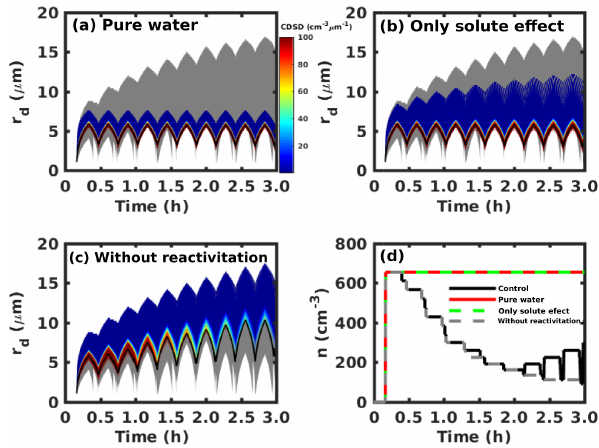
Figure 3. (a) Cloud droplet size distribution (CDSD) changes with time without solute or curvature effects. (b) CDSC changes with time with the solute effect but without the curvature effect. (c) CDSD changes with time including both solute and curvature effects but where droplet reactivation is not considered. (d) Total cloud droplet number concentration ( n ) changes with time for the different cases. The gray region in (a) – (c) represents the range of the droplet size spectrum for the control case, and the black lines represent the mean cloud droplet radius change with